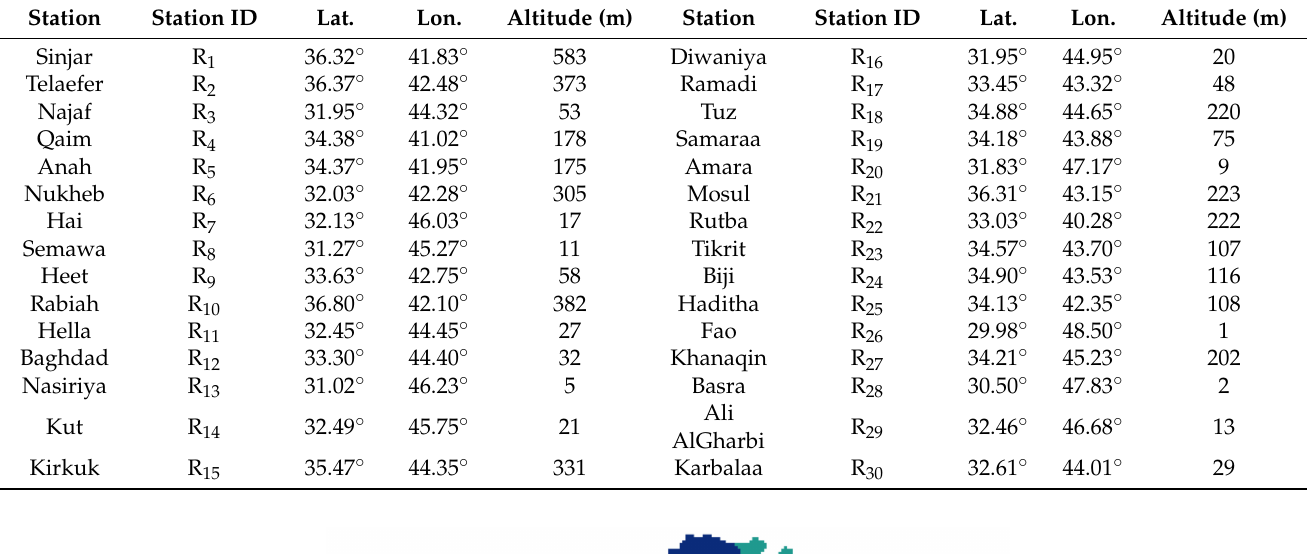
Table 1. Iraqi rain gauge stations used in this study.